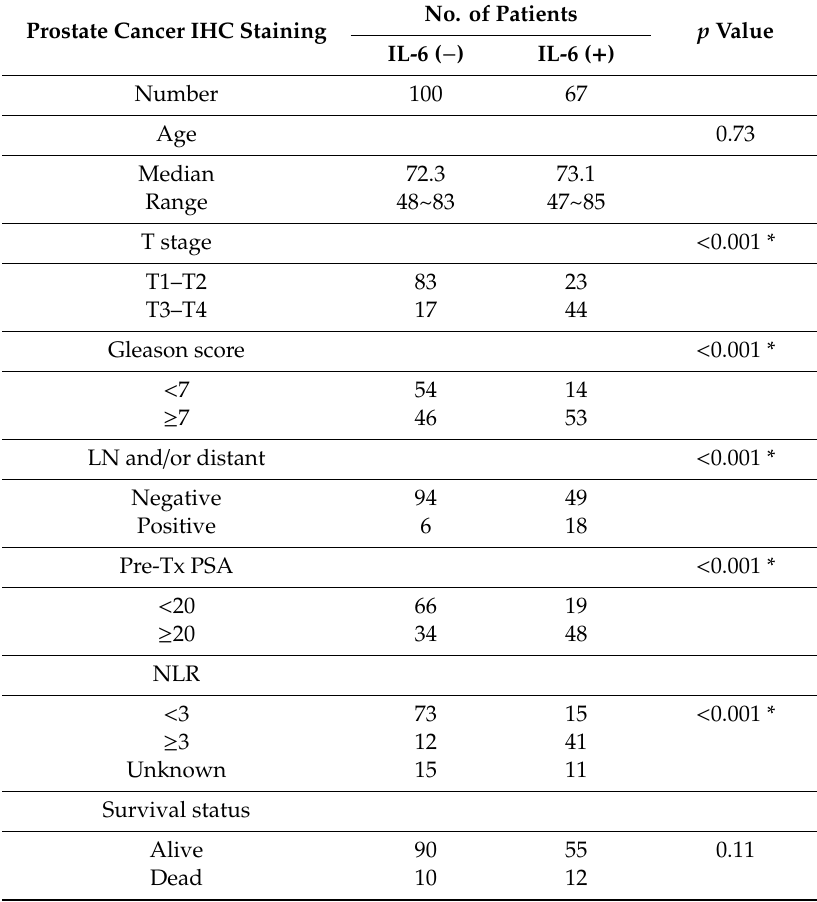
Table 1. Clinical characteristic of